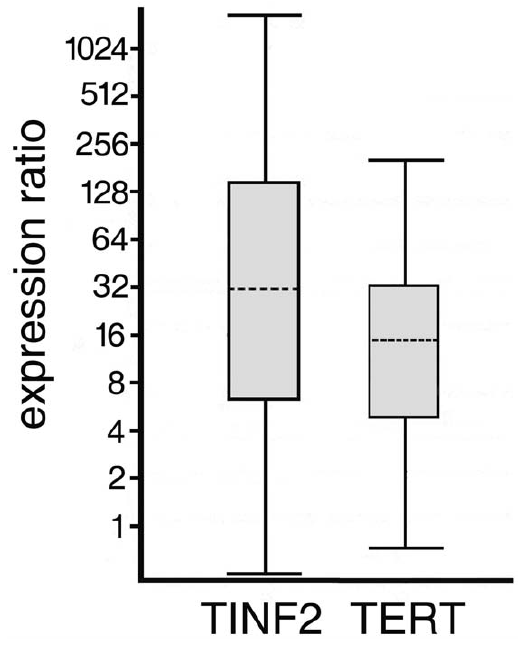
Figure 5. TERT and TINF2 genes are up-regulated in DFT samples compared to spleen (P , 0.0001). Number of samples used in the analysis: tumours N=11 and spleen N=5. Stippled horizontal lines depict mean relative gene expression, boxplots indicate the range of standard error and bars depict 95% confidence intervals.